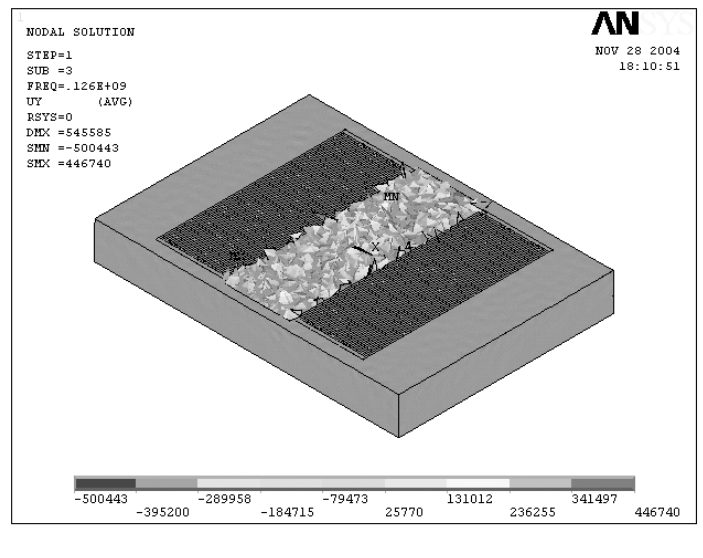
Figure 4. SAW sensor 3D geometry model.